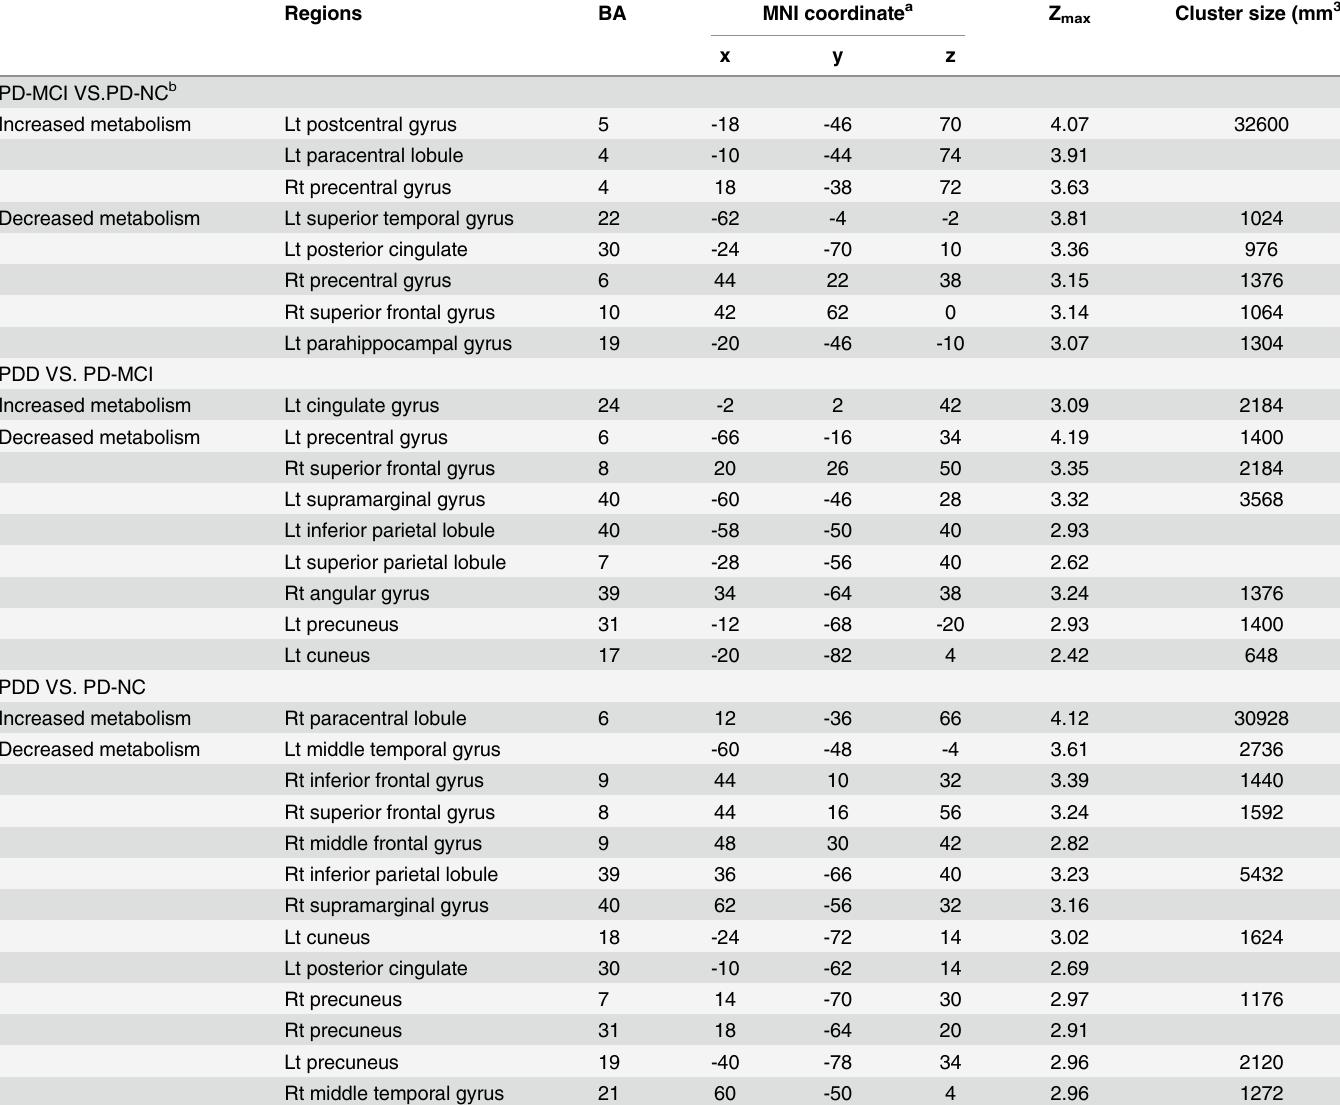
Table 3. Brain regions with significant metabolic differences between PD groups (p < 0.01